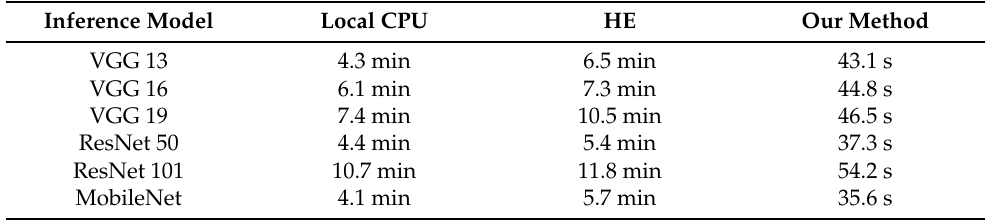
Table 2. Execution time for different methods.